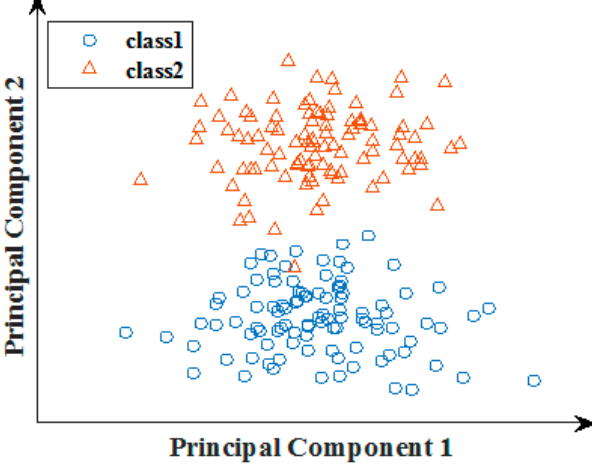
Figure 3. Projecting data in two orthogonal directions.